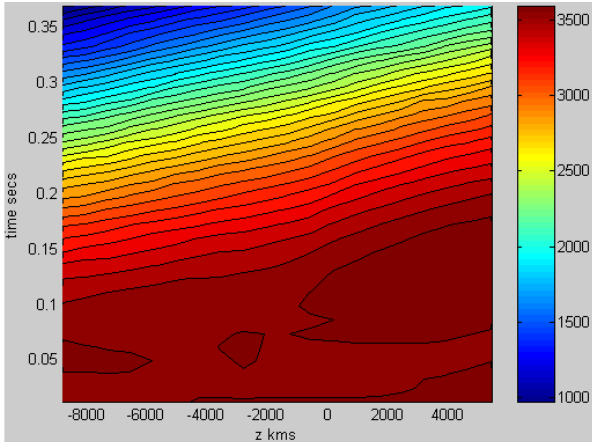
Fig. 20. For falling chorus with Ne=191 electrons/cc, the plot of smoothed localised frequency in the z,t plane for the first element only. The development of a marked negative frequency/wave num- ber gradient across the GR is noted, which is the dominant cause of the frequency sweep.